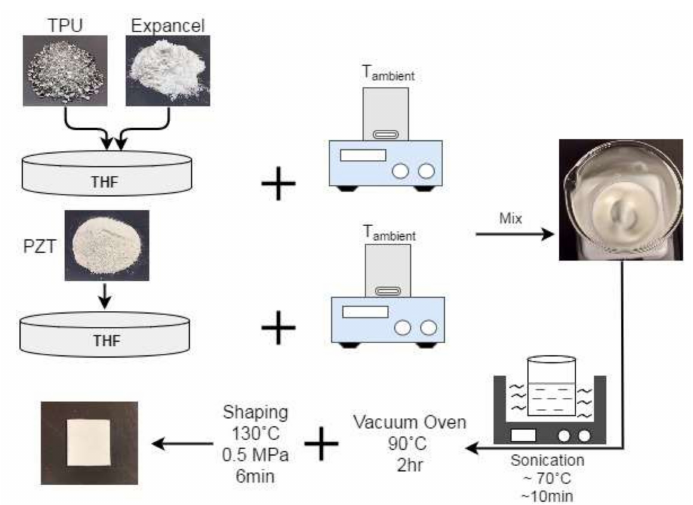
Figure 1. Schematic illustration of the solution casting process. TPU—thermoplastic polyurethane; PZT—lead zirconate titanate;